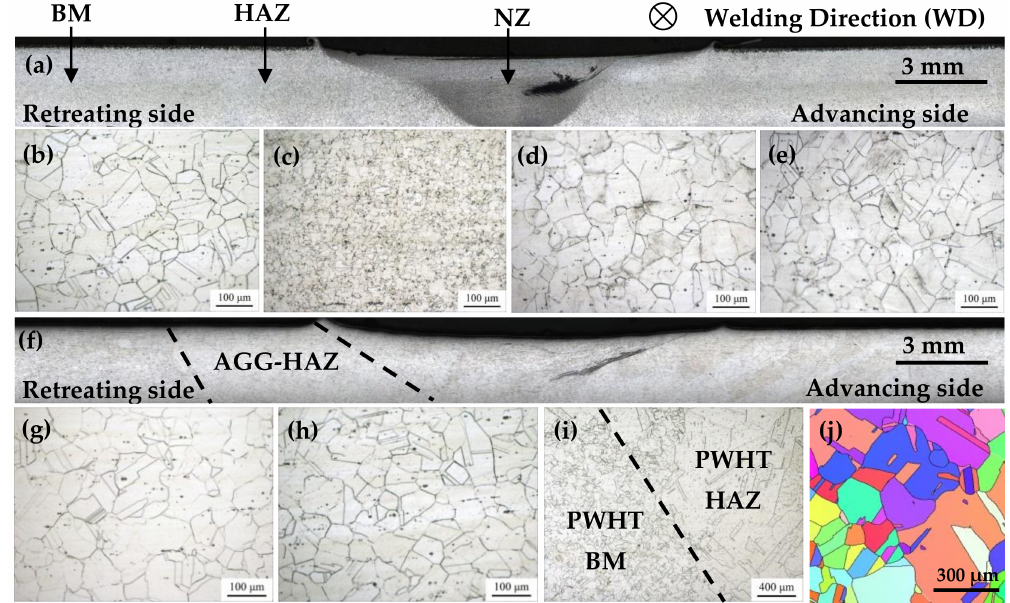
Figure 1. Microstructures in the as-welded and PWHT joints: ( a ) overall cross-section observation of the as-welded joint; ( b ) OM of BM in the as-welded joint; ( c ) OM of NZ in the as-welded joint; ( d ) OM of HAZ in the retreating side of as-welded joint; ( e ) OM of HAZ in the advancing side of as-welded joint; ( f ) overall cross-section observation of the PWHT joint; ( g ) OM of BM in the PWHT joint; ( h ) OM of NZ in the PWHT joint; ( i ) OM of HAZ and BM in the PWHT joint; and ( j ) OIM map of HAZ in the PWHT